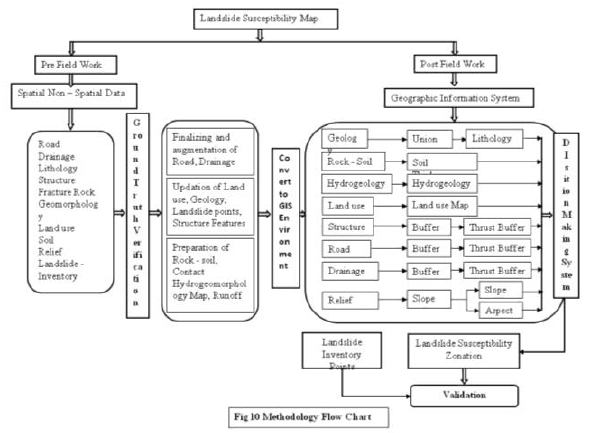
Figure 4 Terrain Flow